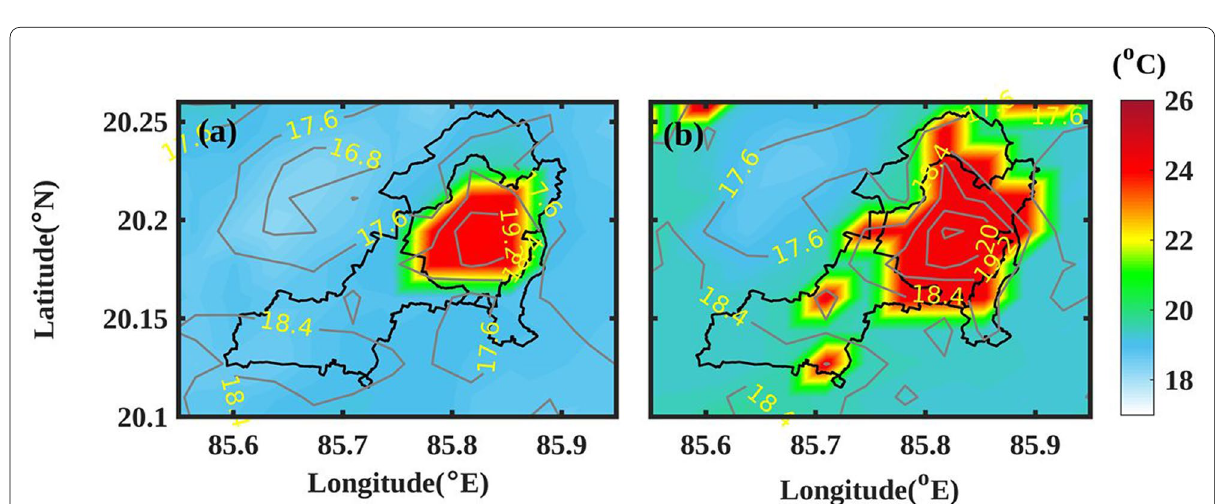
Fig. 3 Comparing model simulated surface skin temperature with MODIS Land surface temperature. ( a ) 2004 ( b ) 2015. The color bar shows model simulated values, and the contour shows the MODIS (Terra)-LST